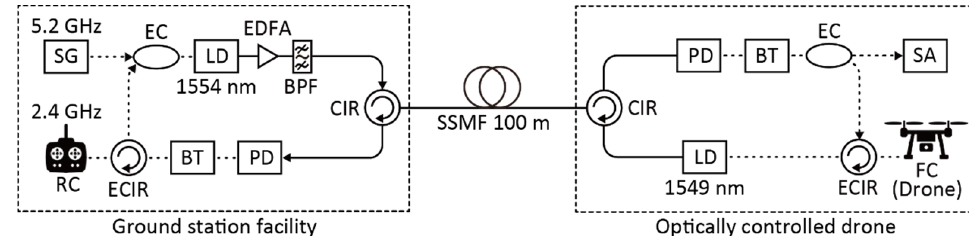
Figure 2. Experimental setup for simultaneous RoF data and control signals transmission for airborne